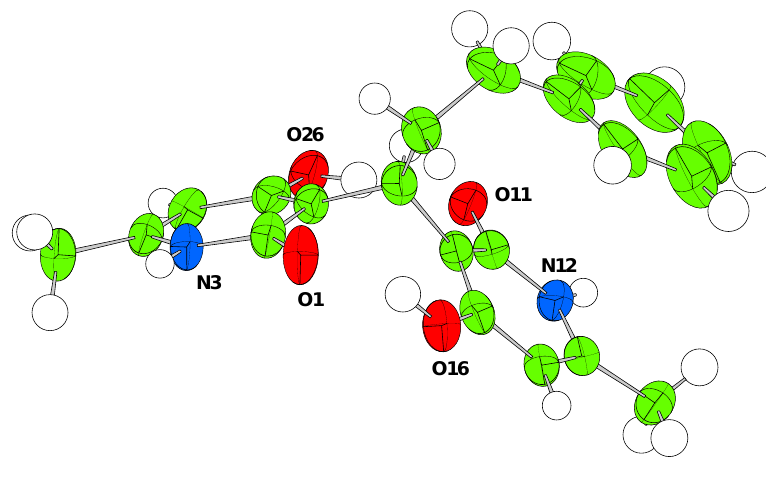
Figure 1. Single crystal structure of compound 4f . Atomic displacement parameters shown at 50% probability and the disorder are omitted for clarity.